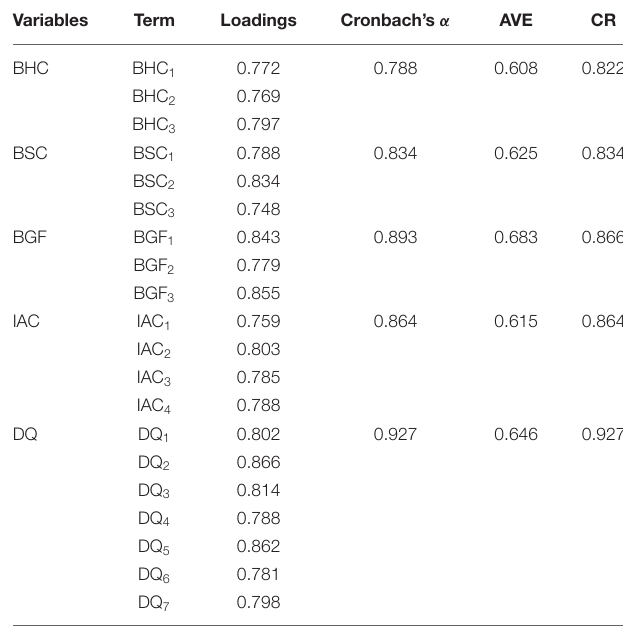
TABLE 2 | Reliability and validity of